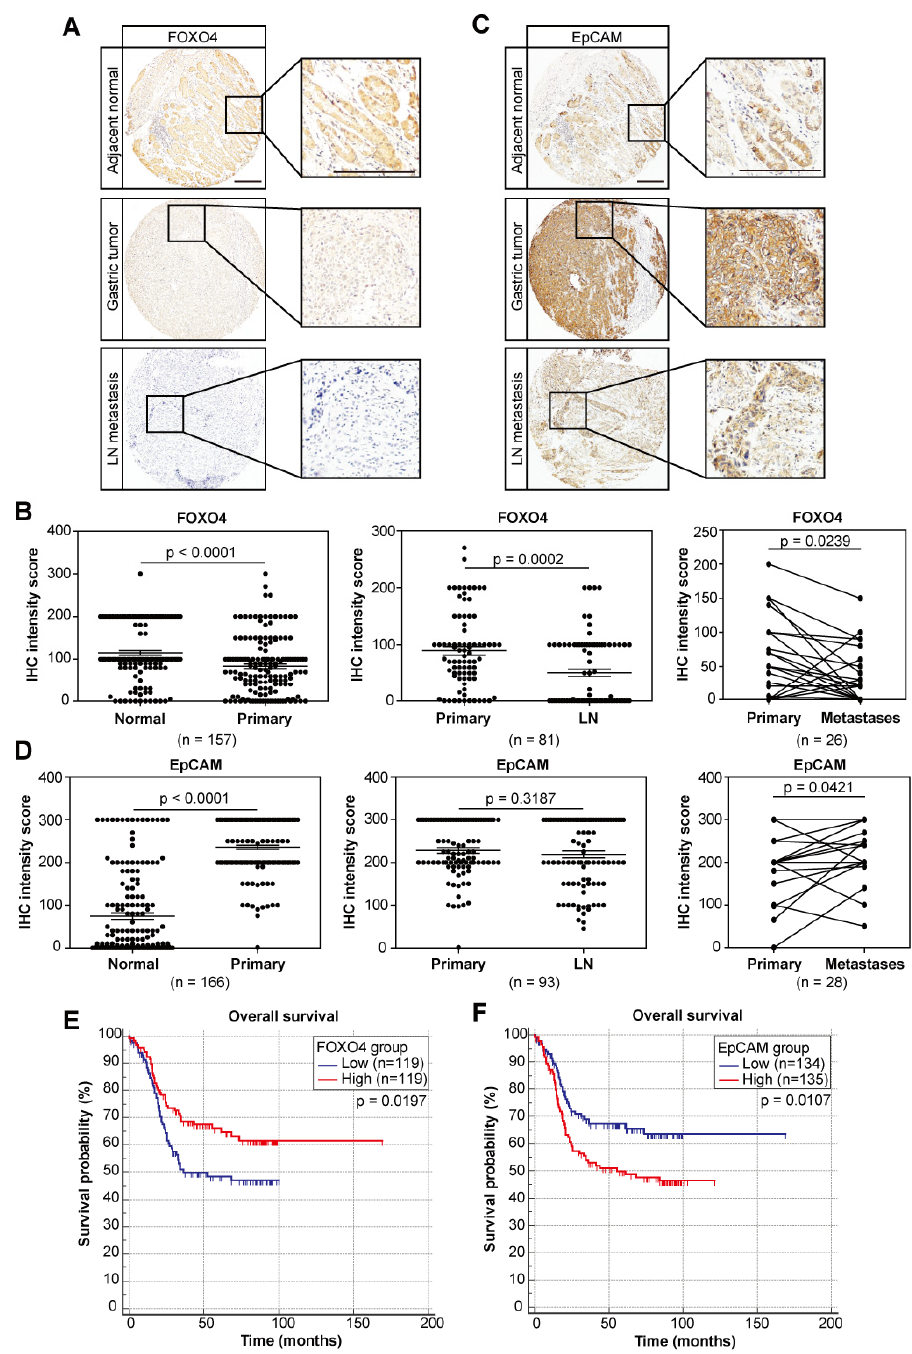
Figure 7. The negative Wnt regulator FOXO4 and the Wnt/ β -catenin target gene EpCAM exhibit prognostic values. ( A , C ) Representative pictures of FOXO4 ( A ) and EpCAM ( C ) IHC staining in normal tissue, primary tumors and lymph node metastases of gastric cancer patients. Scale bars represent 100 µ m. ( B , D ) IHC staining intensities comparing FOXO4 ( B ) and EpCAM ( D ) expression in normal tissue samples vs. paired primary tumors ( left ), primary tumors vs. paired lymph node metastases ( middle ), primary tumors vs. paired distant metastases ( right ). Error bars indicate mean ± SEM. ( E , F ) Kaplan–Meier analysis showing overall survival of gastric cancer patients with high vs. low FOXO4 ( E ) and EpCAM ( F ) expression. Median value of FOXO4 or EpCAM IHC intensities is used as cut-off to separate low and high groups.